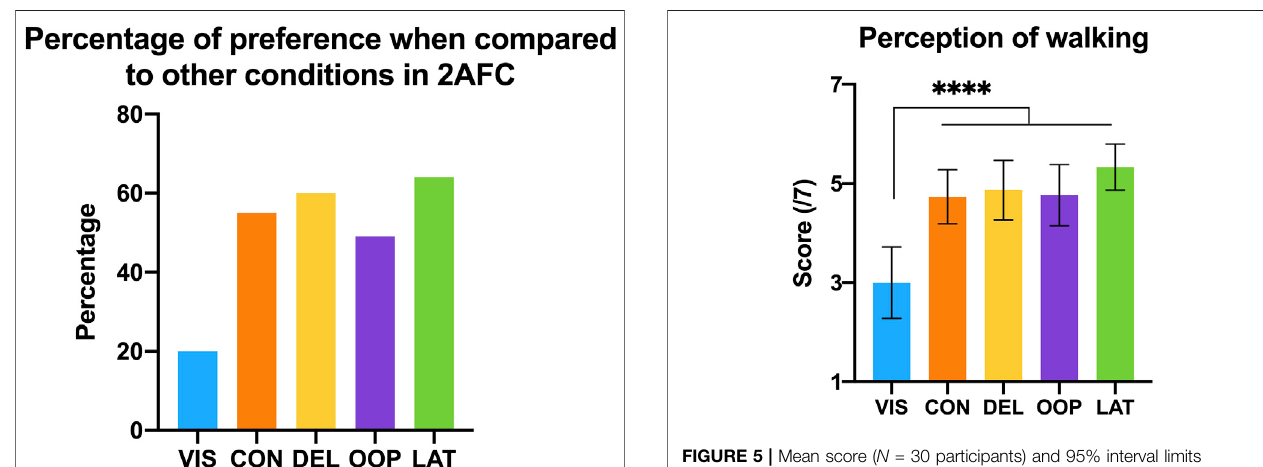
FIGURE 5 | Mean score ( N (cid:2) 30 participants) and 95% interval limits obtained in the second phase of the experiment, for the Perception of walking question (/7)foreachcondition.VIS,Visual-onlycondition(novibration);CON, congruent condition; DEL, delayed condition; OOP, out-of-phase condition; LAT, lateralized condition. ****Indicates statistical signi fi cance, p <